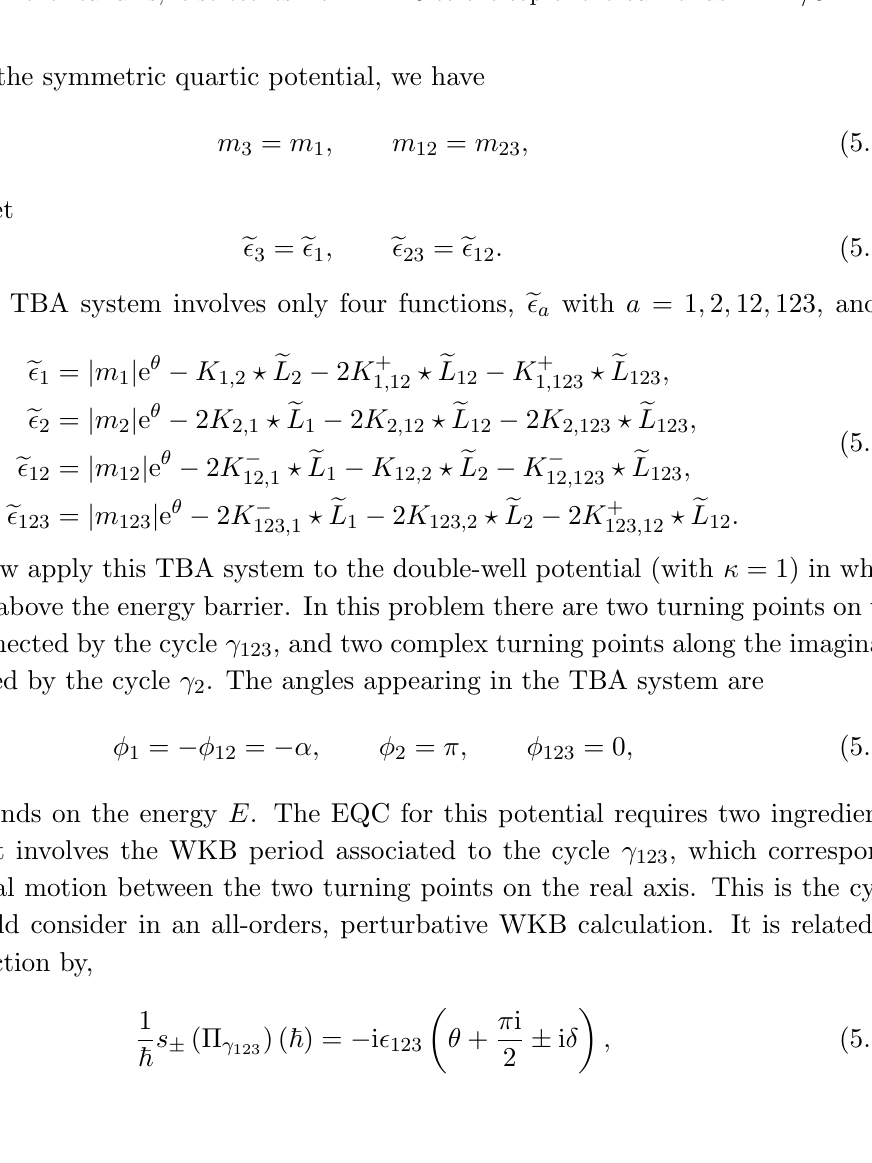
Figure 12 . The curve of marginal stability for the quartic oscillator with (cid:20) = 1, in the complex energy plane. In the real axis, it stretches from E = 0 to the top of the barrier at E = 1 =